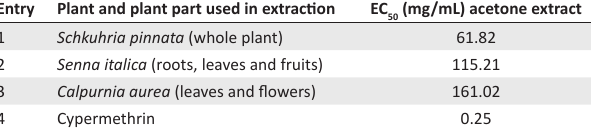
TABLE 3: The EC values of selected acetone extracts. 50 Entry Plant and plant part used in extraction